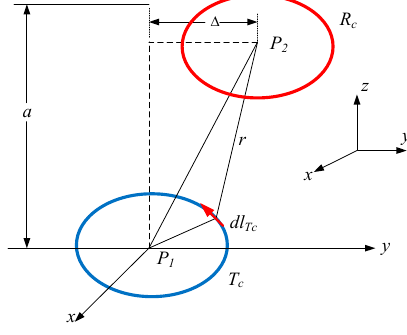
Figure 2. Circular coil geometry set.